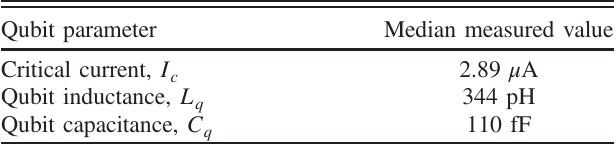
TABLE I. Qubit parameters.